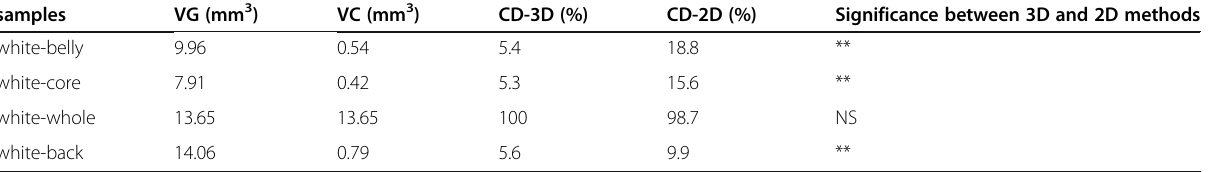
Table 2 Chalkiness quantification of rice kernel samples with different chalkiness types samples